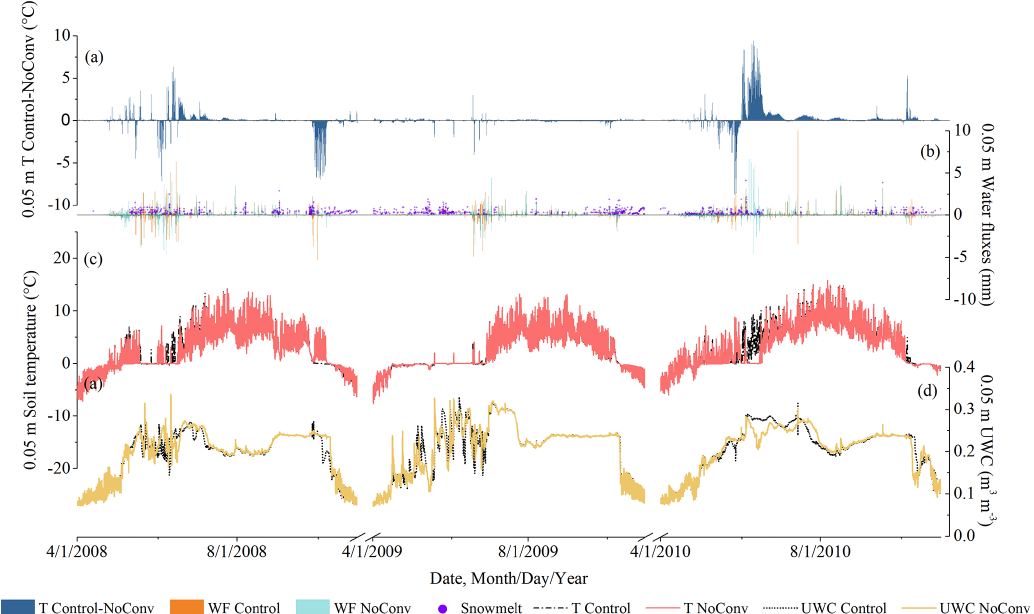
Figure 7. Hourly soil temperature, water flux, and UWC at 0.05m depth simulated under NoConv and Control during the 2008–2010 thaw periods. From top to bottom are as follows: (a) the differences in soil temperature ( T ) between Control and NoConv (Control–NoConv), with positive values indicating heating effects and negative values indicating cooling effects; (b) snowmelt water simulated under Control and the water fluxes (WFs) simulated under NoConv and Control, in which positive values represent downward flows and negative values upward flows; and (c) soil temperatures and (d) UWCs simulated under NoConv and